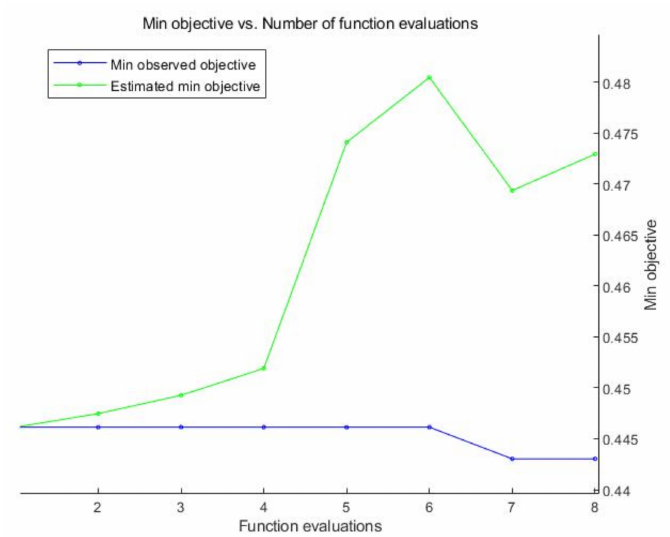
Figure 8. Hyperparameters optimization process by BO.